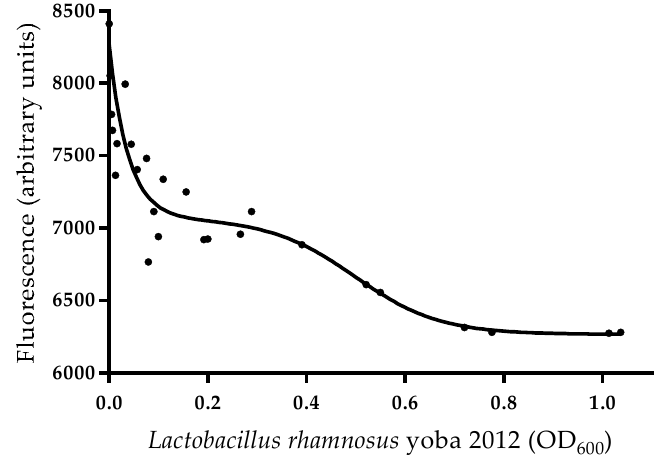
Figure 4. Lactobacillus rhamnosus yoba 2012–aflatoxin B 1 binding Figure 4 . Lactobacillus rhamnosus yoba 2012–aflatoxin B 1 binding curve.